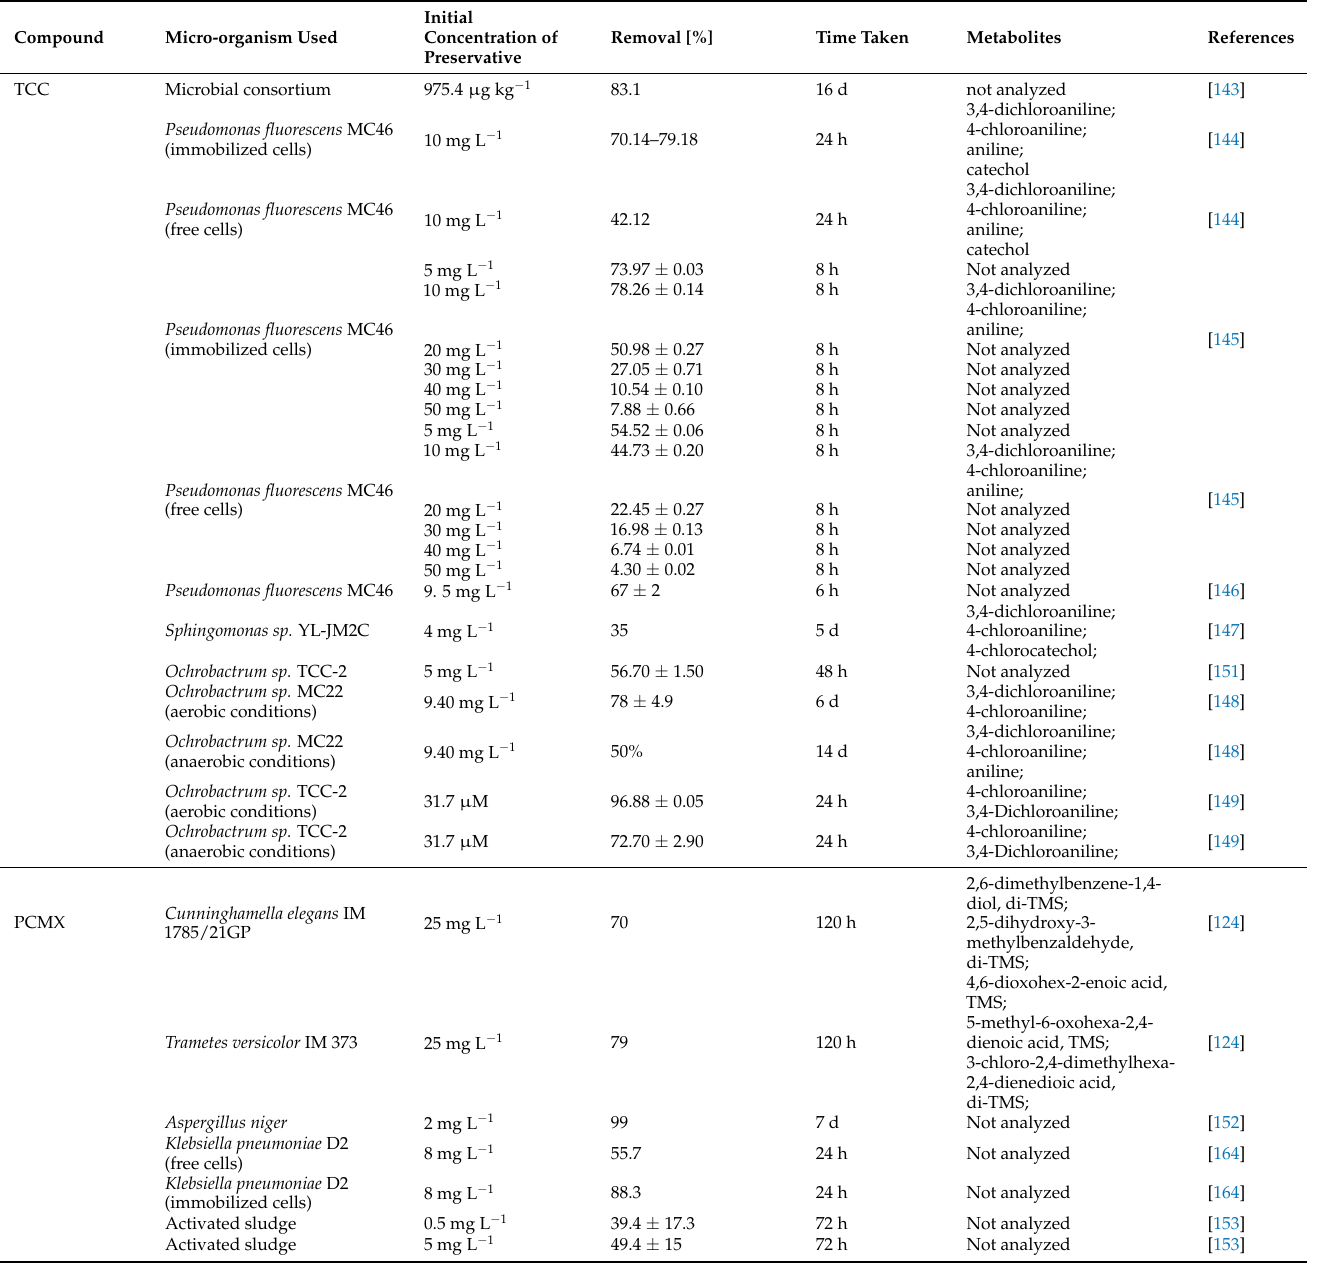
Table 4. Microbial degradation of cosmetic